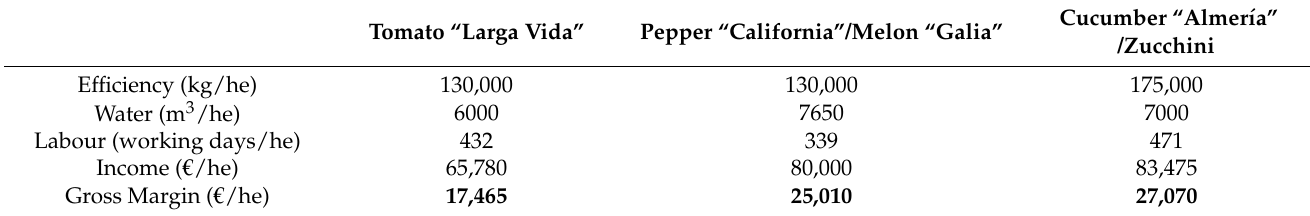
Table 6. Relevant Indicators for the Three Crop Alternatives